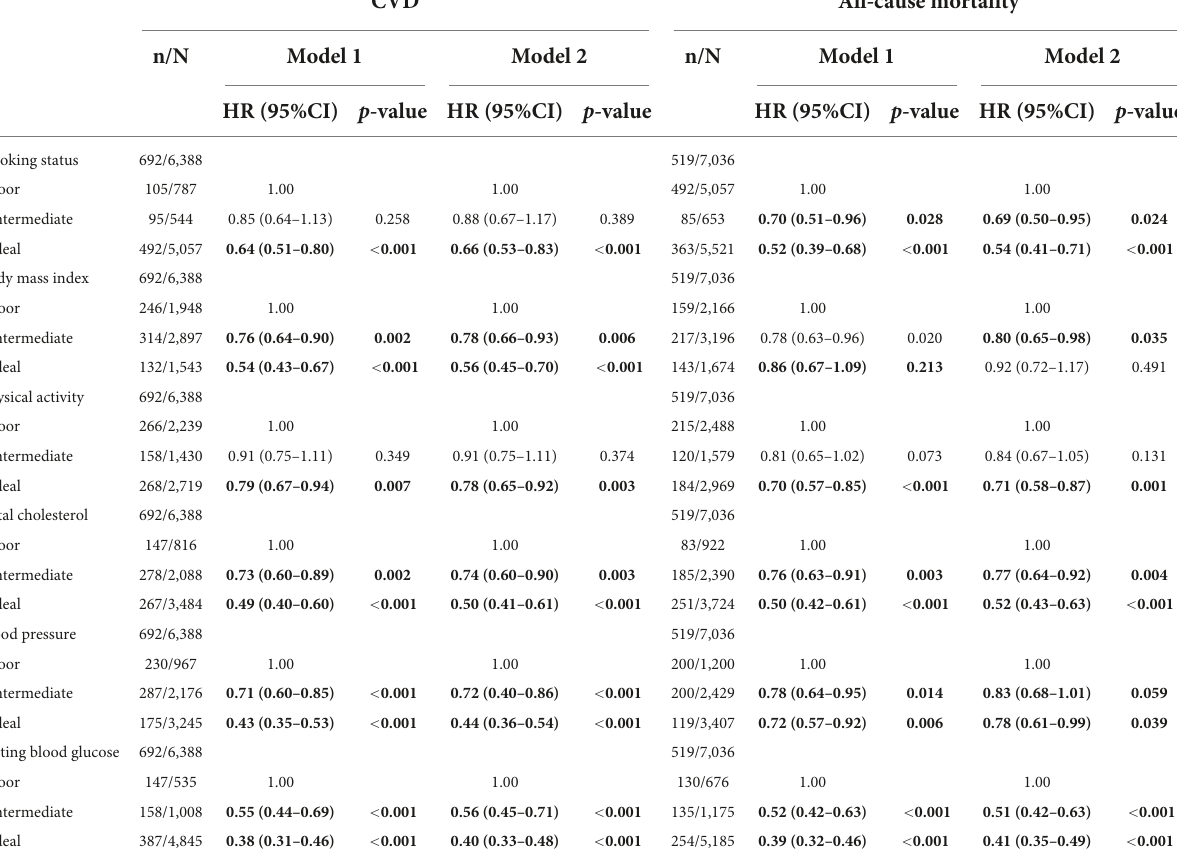
TABLE 2 The risk of intermediate and ideal status for each metrics for cardiovascular disease and all-cause mortality: Tehran Lipid and Glucose Study (TLGS), 2005–2018.